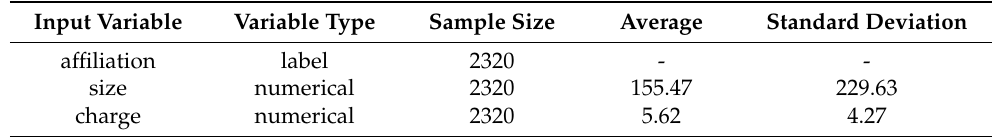
Table 2. The input variables of two-step